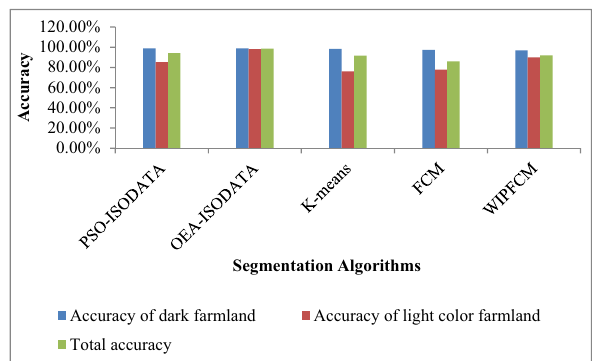
Figure 6: Segmentation accuracy of di ff erent algorithms for farmland